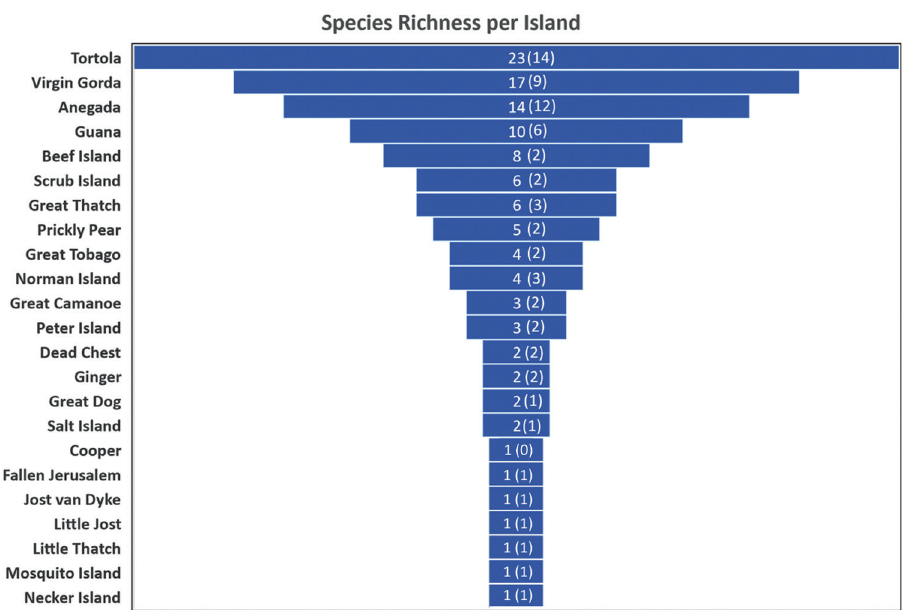
Figure 2. Species richness across the BVI archipelago. Data show number of Species of Conservation Concern (SCC) recorded in each island. Numbers in () correspond to globally threatened